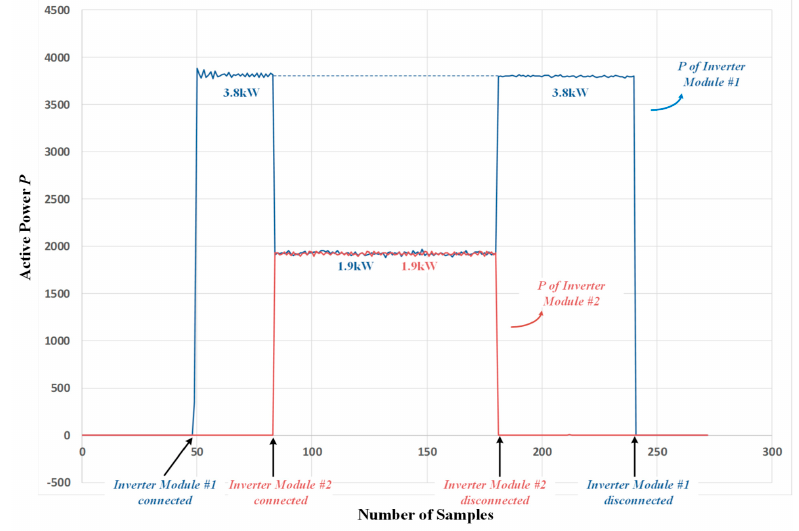
Figure 17. Experimental result of active powers of each inverter module in using the proposed control strategy.